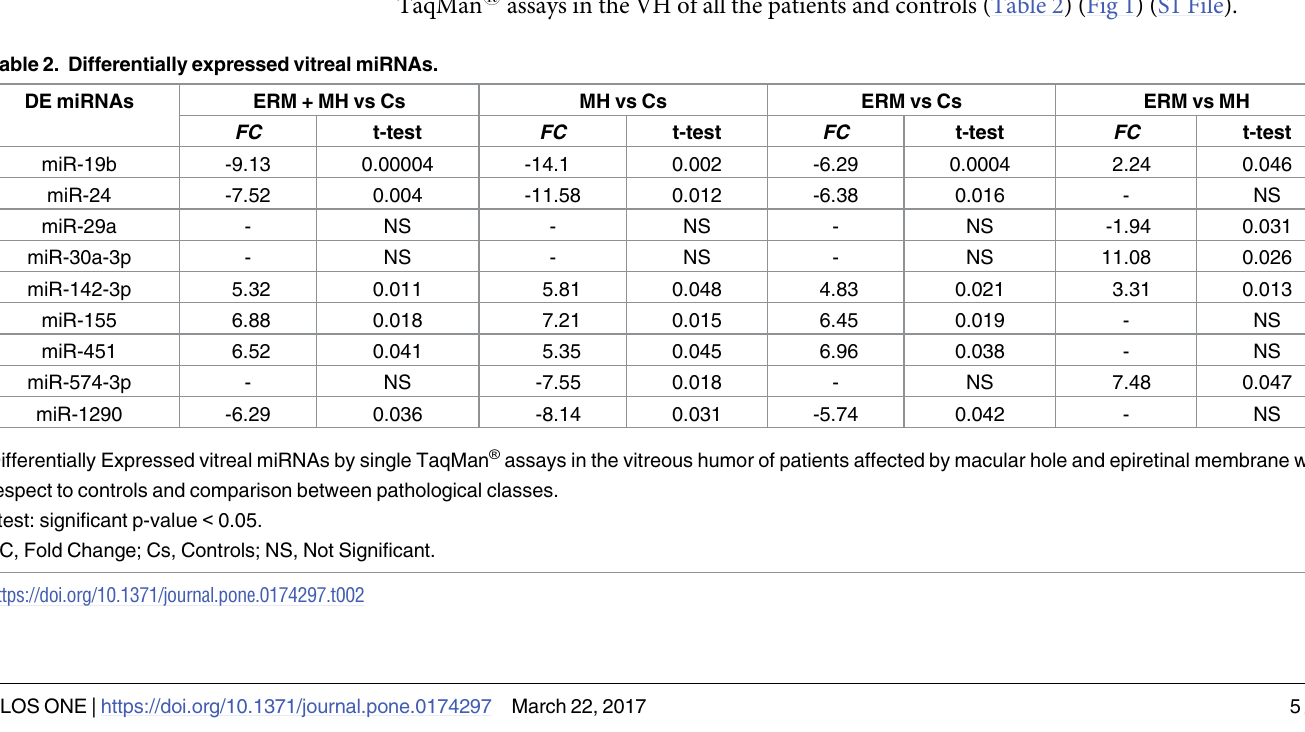
More specifically, we found 4 downregulated miRNAs (miR-19b, miR-24, miR-155, miR- 451) and 1 upregulated miRNA (miR-29a) in patients affected by MH and ERM with respect to controls; while, 2 downregulated miRNA (miR-29a, miR-142-3p) and 3 upregulated (Table 1). Profiling data showed that 4/5 of differentially expressed miRNAs had a negative FC, suggesting a general trend of downregulation of circulating miRNAs in the VH of eyes with MH and ERM with respect to controls. miR-30a-3p, miR-574-3p, miR-1290 were statisti- cally more abundant in the VH of ERM patients than MH patients.